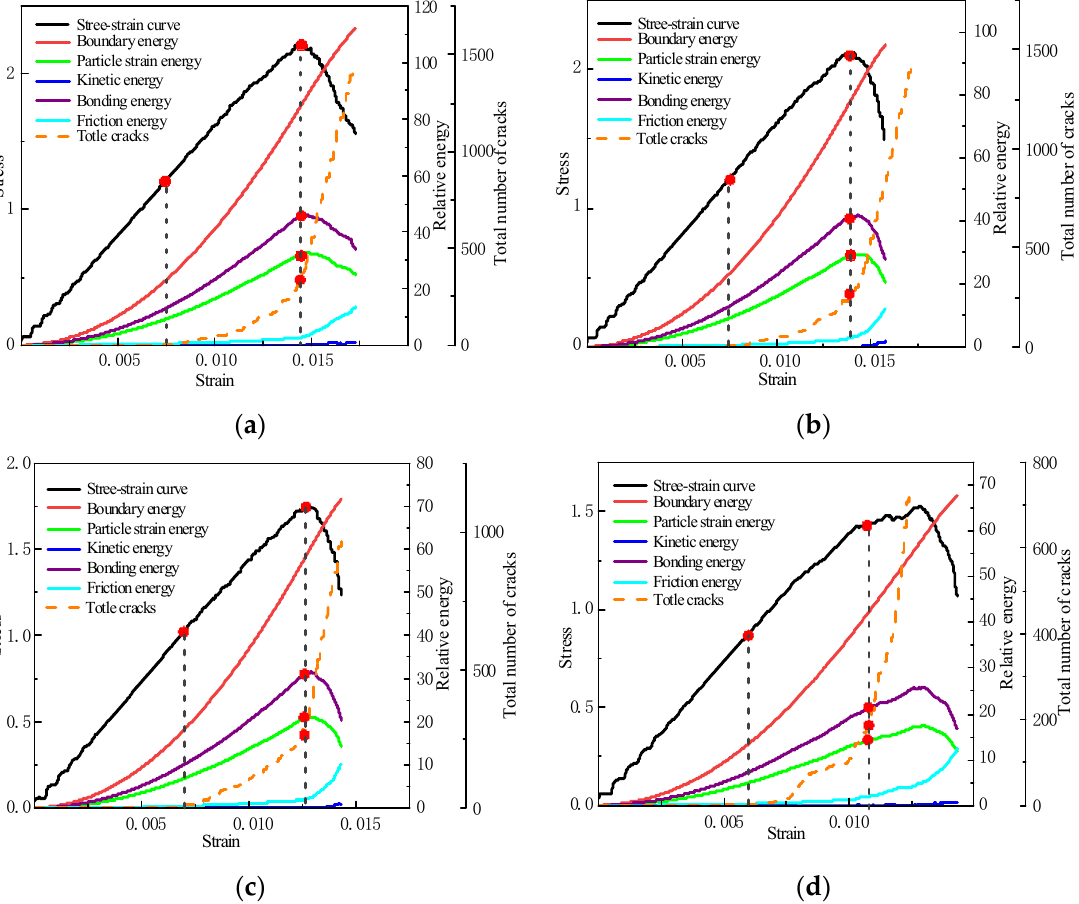
Figure 9. Energy conversion and stress–strain curve; ( a ) one layer, ( b ) two layers, ( c ) three layers, ( d ) four layers.